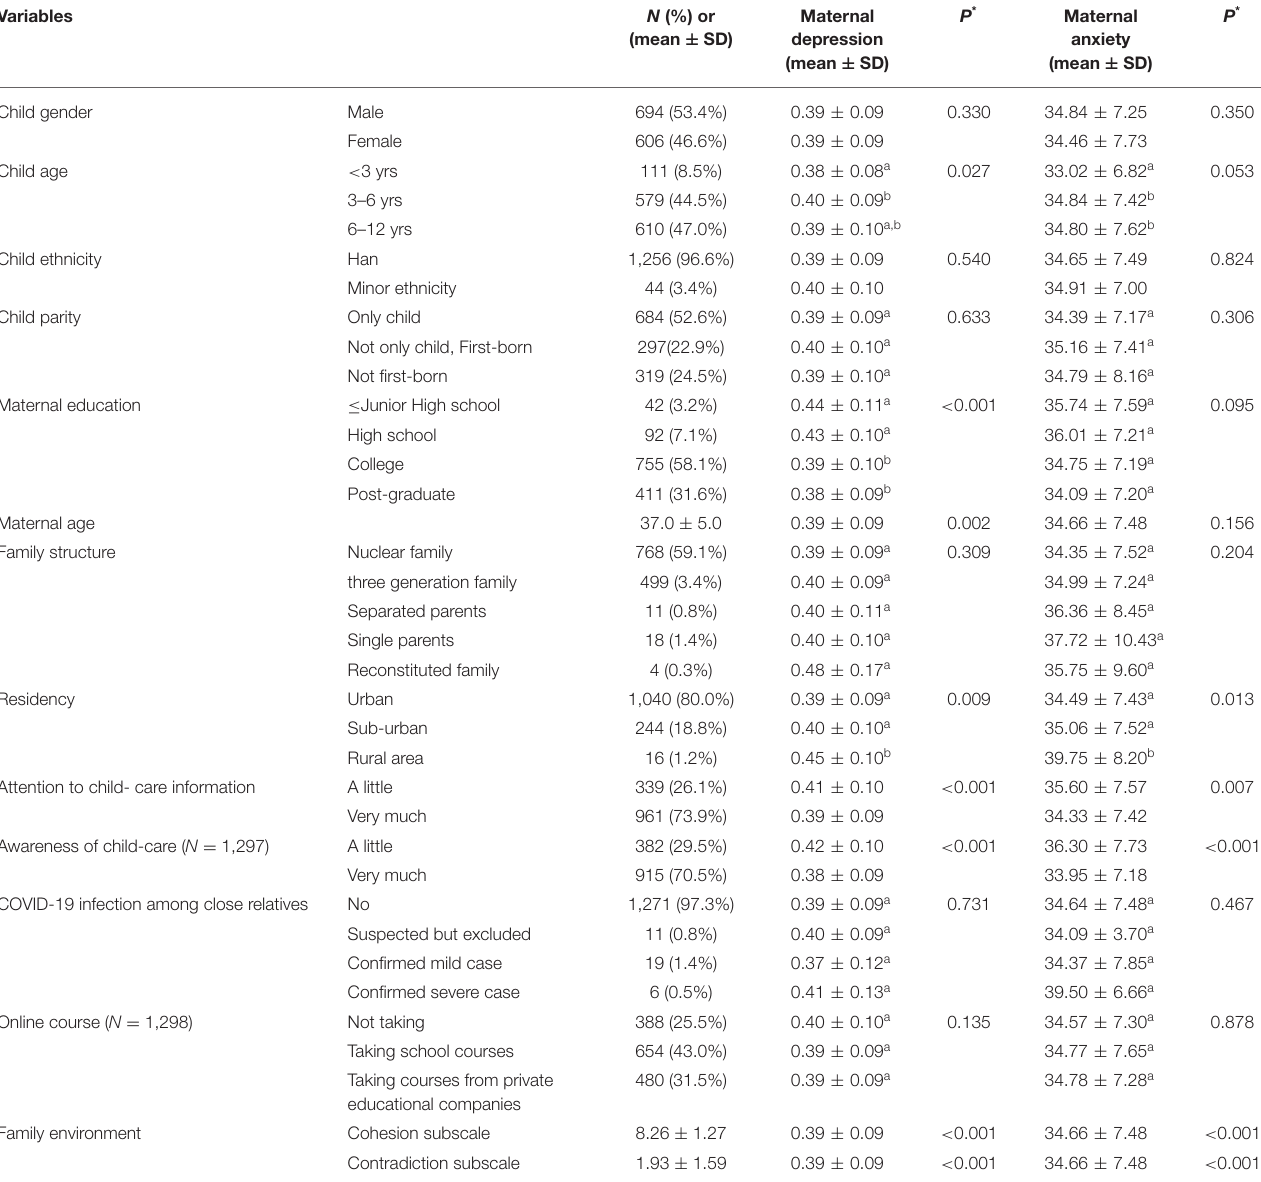
TABLE 1 | Basic characteristics of the study mother-child pairs ( N = 1,300).